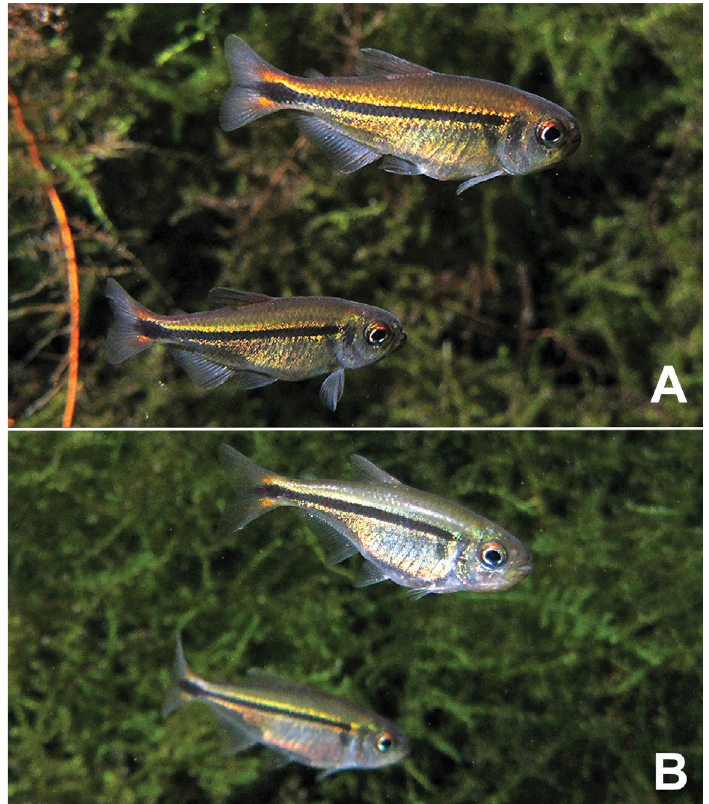
FIGURE 4 | Underwater photographs of wild specimens of Astyanax nobre at its type locality Recanto Ecológico Lagoa Azul, Bom Jardim district, Municipality of Nobres, Mato Grosso State, rio Salobra drainage, rio Paraguai basin: A. Pair of males; B. Pair of females. Details about differences between sexes can be found in Sexual dimorphism section. Photo by M.